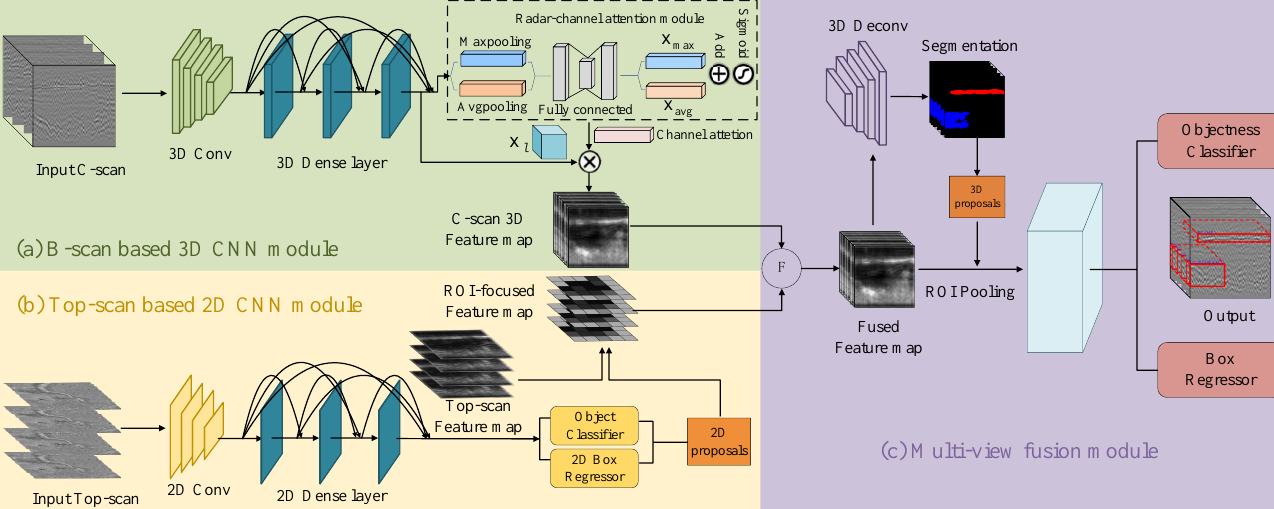
Figure 5. Architecture of the proposed MV-GPRNet. The framework consists of three components: ( a ) B-scan-based 3D CNN module (green block): a 3D CNN is designed to extract the 3D feature map from C-scan data. ( b ) Top-scan-based 2D CNN module (yellow block): It first generates 2D object proposals from the top view map and projects them to the 2D feature map. ( c ) Multi-view fusion network (purple block): A fusion network is used to combine multi-view features via region alignment. The fused features are used to generate 3D proposals and jointly predict object class and perform 3D box regression after the ROI-pooling